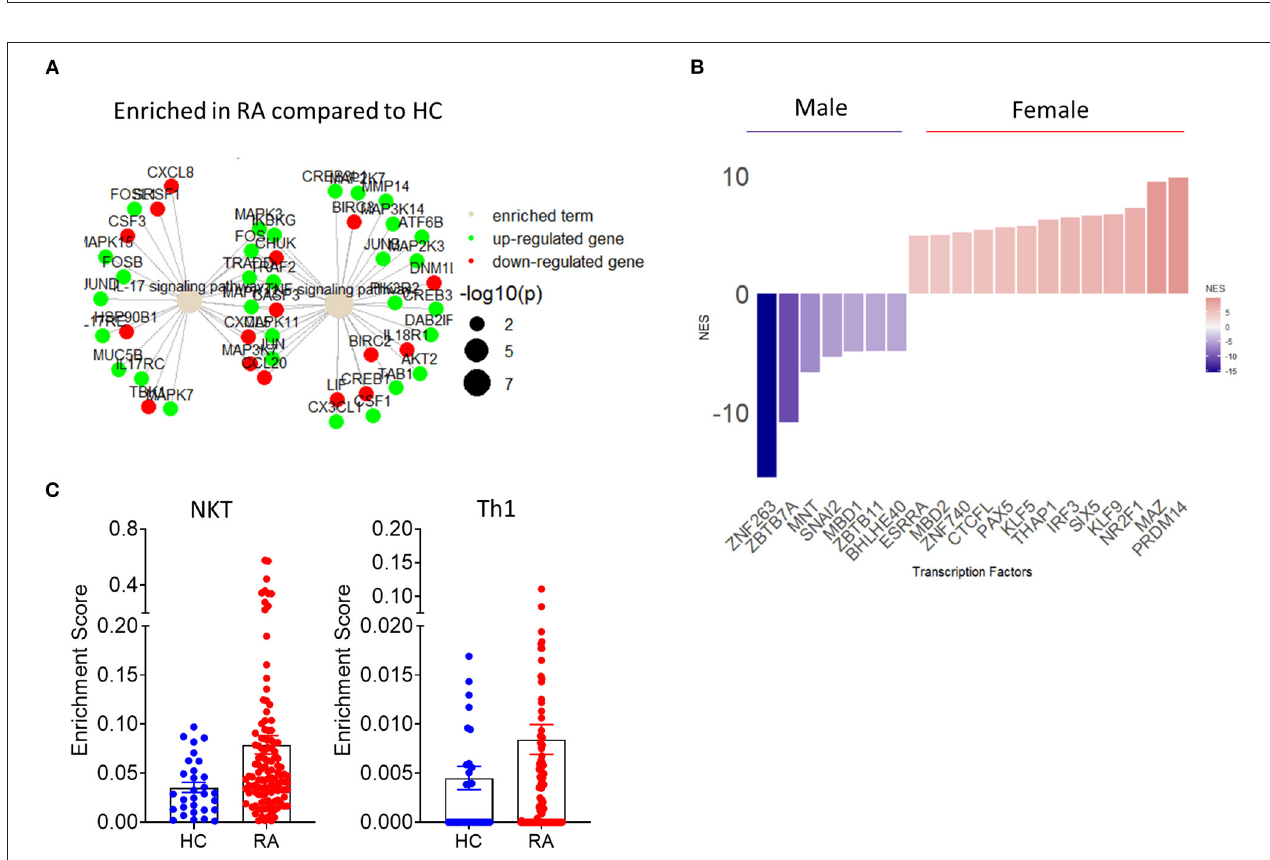
FIGURE 4 | Implementation of transcriptomics in the study of synovial inflammation. (A) Term plot following pathway enrichment analysis of RA and HC synovial tissue biopsies. Only significantly upregulated (green) or downregulated (red) gene members of the pathway are shown. Gene dot size represents significance of change for the corresponding gene. (B) Transcription factor usage score of female compared to male RA patients based on differential expression of know target genes. (C) RA patient and HC synovial tissue enrichment scores for specific cell populations based on transcriptional signature deconvolution of bulk RNAseq